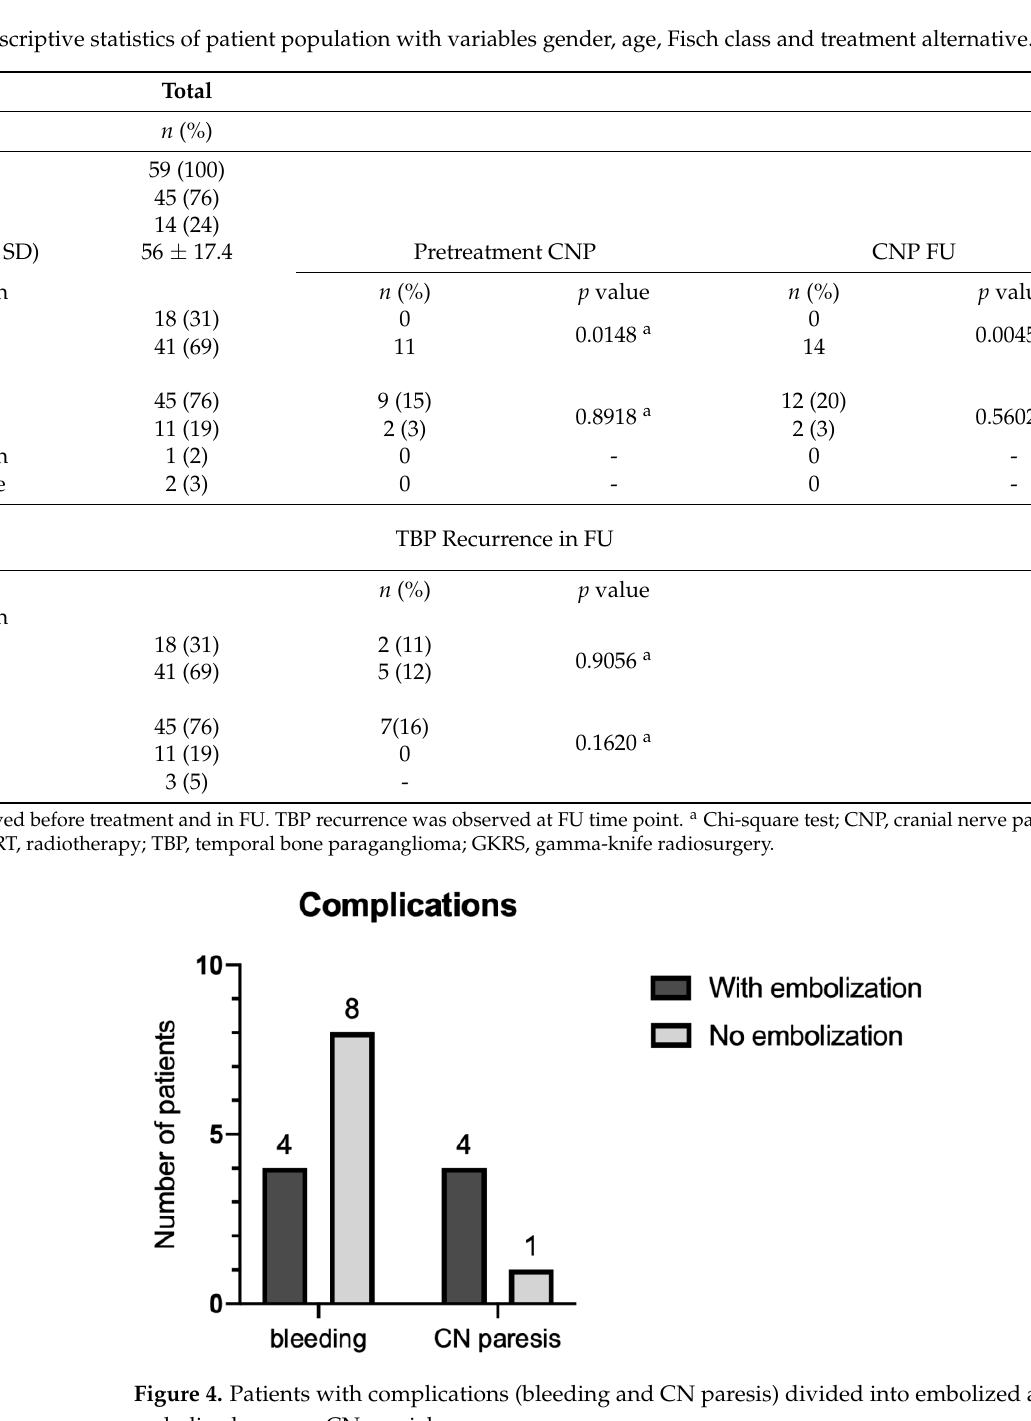
Figure 5. Kaplan – Meier curve and log-rank test of recurrence free patients over the long-term fol- low-up period. No significant differences between Fisch A to D TBPs were observed ( p = 0.3192). TBP — temporal bone paraganglioma.